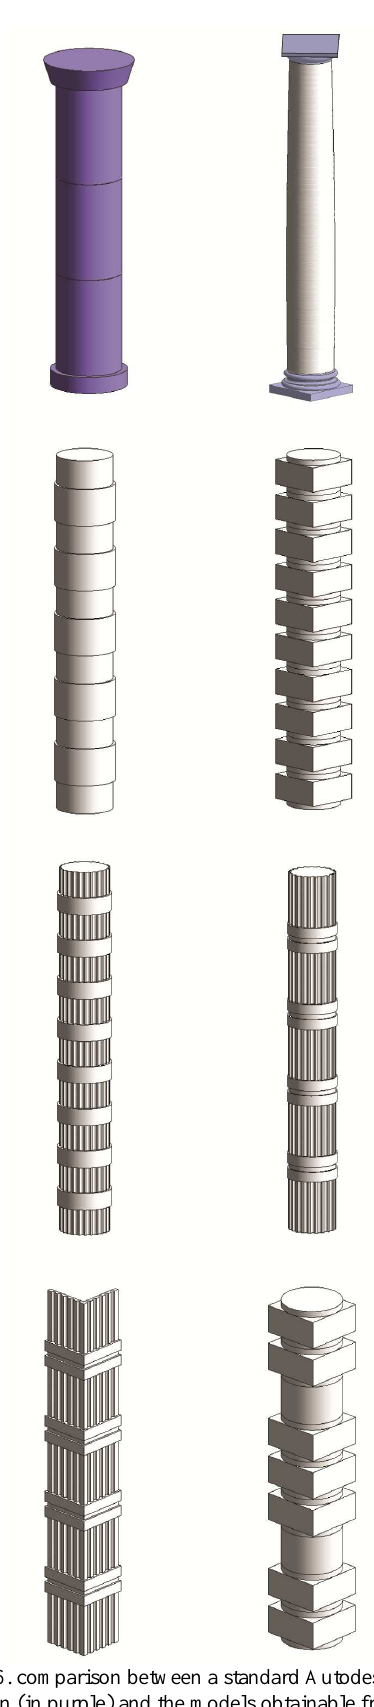
Figure 16. comparison between a standard Autodesk Revit® column (in purple) and the models obtainable from the developed algorithm